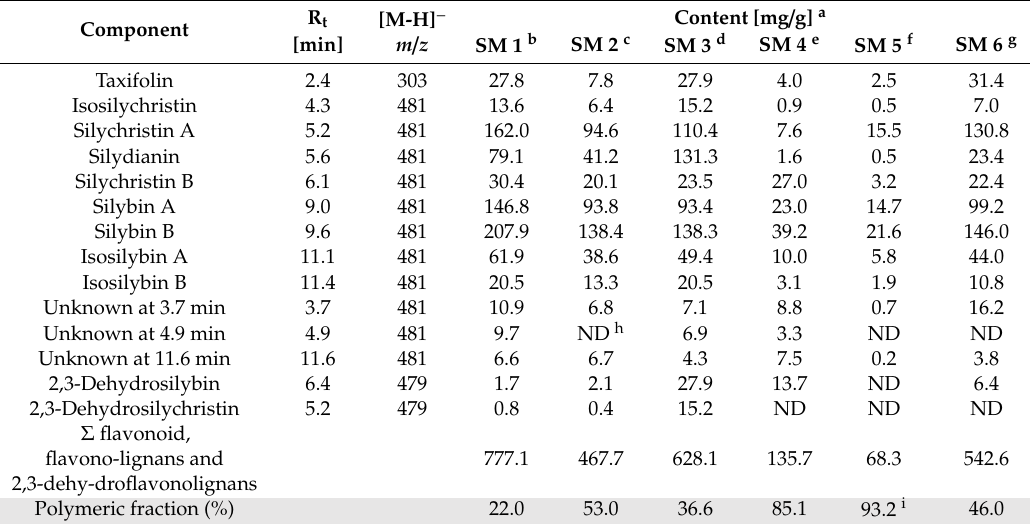
Table 2. The content of individual flavonoid, flavonolignans, and 2,3-dehydroflavonolignans in silymarin